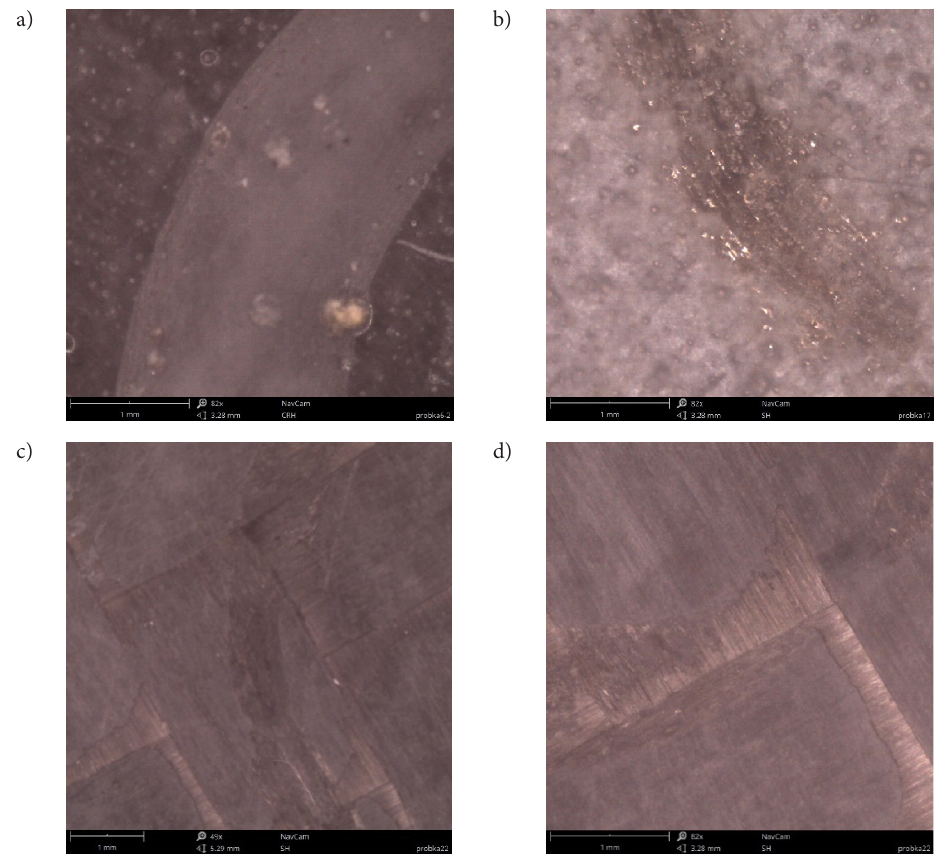
Figure 14. Sample micrographs of abrasions on a material sample: a) epoxy, b) Super Metal, c) and d)